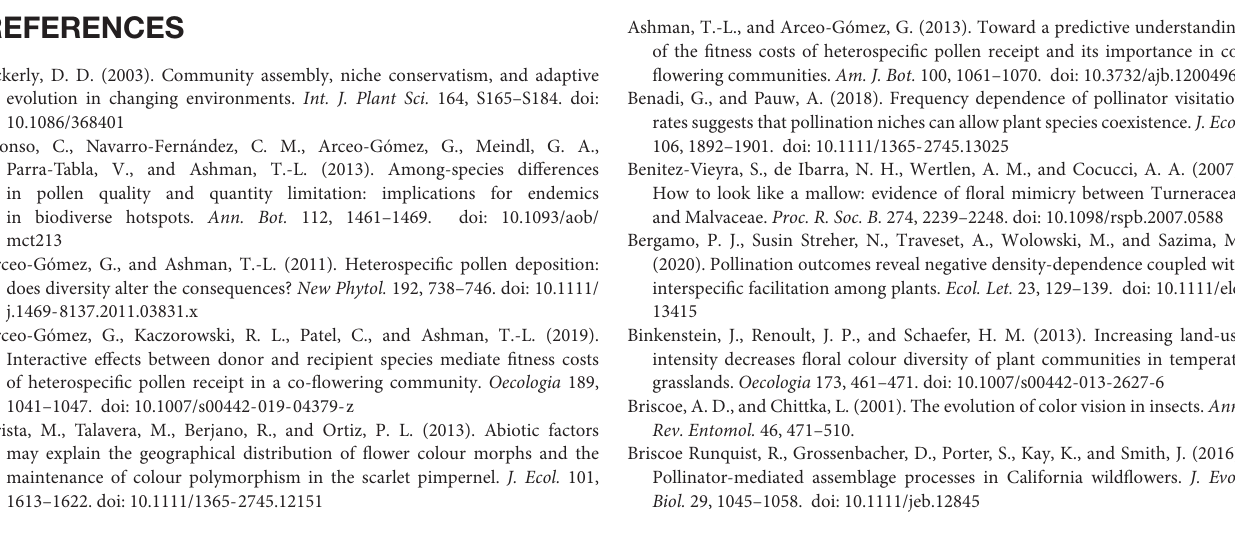
line representing cumulative proportion, solid line representing proportion. (B) Eigenvalues of Principal Component Axes. Supplementary Figure 2 | Phylogenetic tree of 55 plant species used in study. Circles are colored to represent human vision interpretation of flower color. Branch length reference unit of 10 represents 10 Mya. Supplementary Table 1 | List of 55 plant species used in study, along with community membership and flower visitor information. Seep sites are ordered by increasing species richness. An X in the “F” Visit column denotes that a focal plant species is visited by fly species, an X in the “B” Visit column denotes that a focal plant species is visited by bee species. Supplementary Table 2 | Correlation panel for species richness, seep area, and plant density. Supplementary Table 3 | principal component loadings for species richness, seep area, and plant density. Supplementary Table 4 | Details of spectra collection parameters for each plant species. Supplementary Table 5 | Descriptions of noted color differences within the flowering unit of each plant species in the study. Supplementary Table 6 | Estimated z-scores of each observed seep mean (cid:49) S t compared to null community mean (cid:49) S t for bee vision model using all plant species regardless of known insect visitation. Supplementary Table 7 | Estimated z-scores of each observed seep mean (cid:49) S t compared to null community mean (cid:49) S t for fly vision model using all plant species regardless of known insect visitation. Supplementary Table 8 | Estimated z-scores of each observed seep mean (cid:49) S t compared to null community mean (cid:49) S t for bee vision model only using plant species known to be visited by bees. Supplementary Table 9 | Estimated z-scores of each observed seep mean (cid:49) S t compared to null community mean (cid:49) S t for fly vision model only using plant species known to be visited by flies.